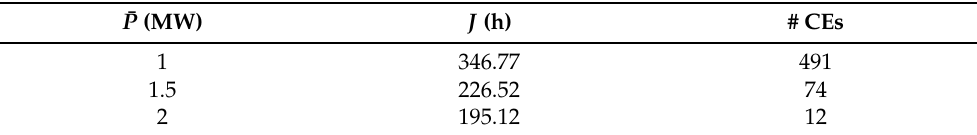
Table 4. Sum of charging times J and number of CEs in the case of ¯ P ∈ { 1,1.5,2 }